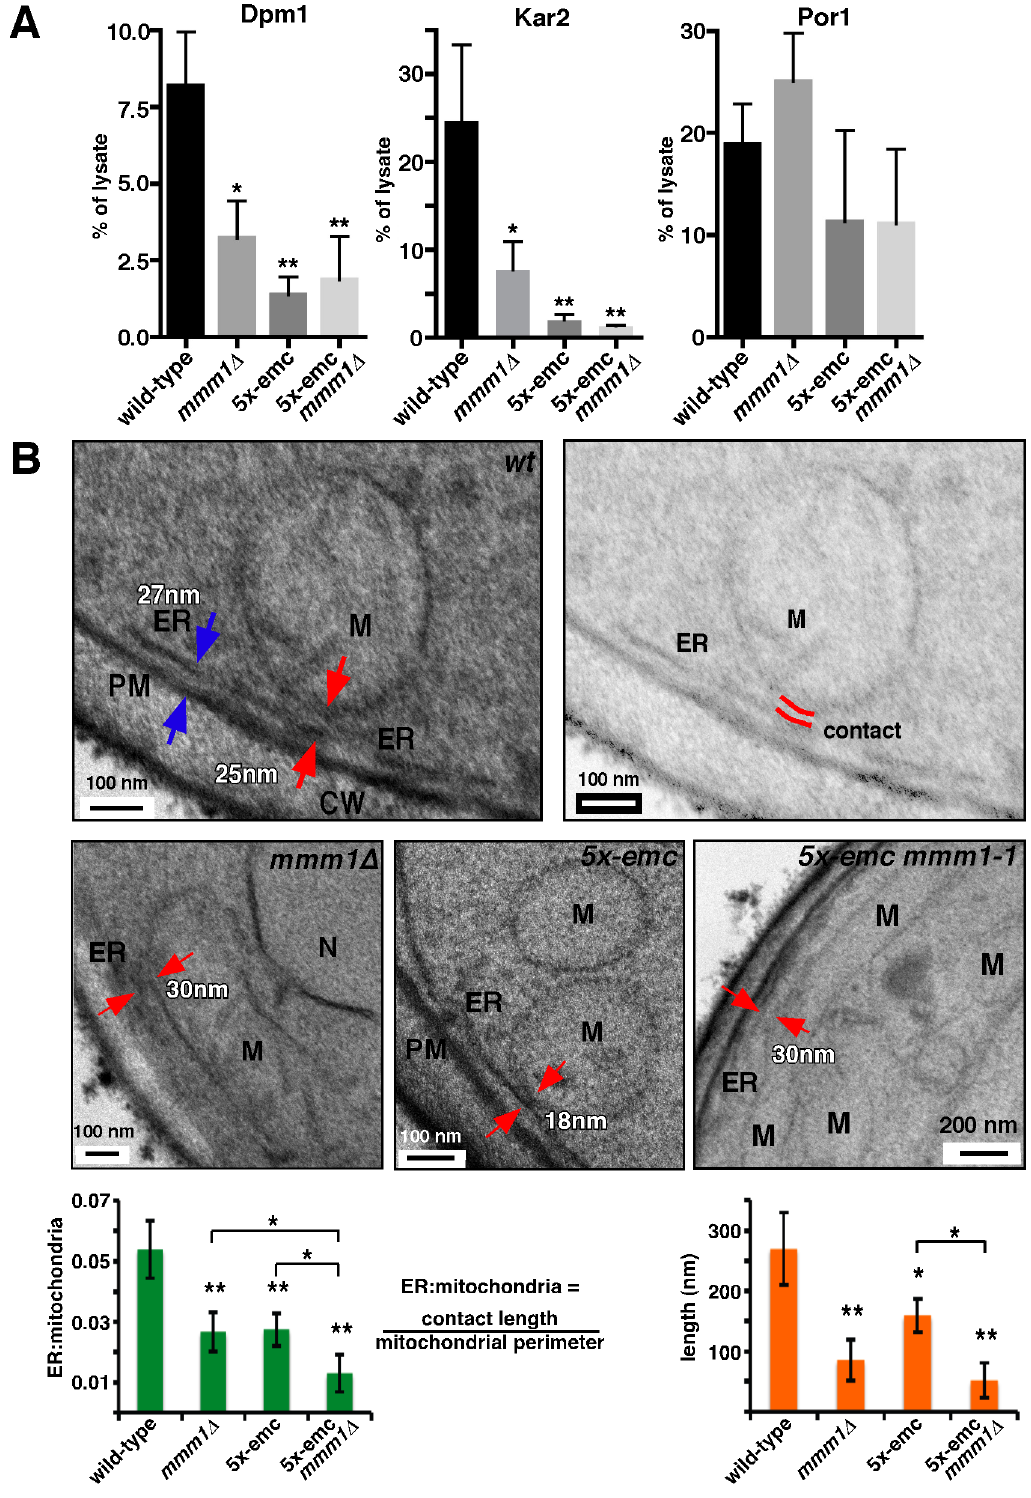
Figure 7. Cells lacking the EMC or the ERMES complex have reduced ER-mitochondria contacts. (A) Mitochondria were purified from the indicated strains and the percent of the ER proteins Dpm1 or Kar2 and the mitochondrial protein Por1 determined (mean 6 s.d., n =3 independent experiments). (B) Representative EM image shows a portion of a wild-type cell (top left). The same image is shown with reduced contrast (top right) to indicate the length of ER to mitochondria contact, highlighted with red lines. EM images showing portions of mutant cells are shown in the middle panels. Red arrows indicate a contact between the ER and mitochondria (M), and the blue arrows show a contact between the ER and the plasma membrane (PM). The bottom panels show the average ER–mitochondria ratio and average length of contacts (mean 6 s.d., n =15 individual cells). The ER–mitochondria ratio was determined by measuring the length of contacts between the ER and mitochondria divided by the length of mitochondrial perimeter in each image. * p , 0.05, ** p , 0.005 compared to wild-type, independent two-tailed t test. The data used to generate the graphs are in Table S7. doi:10.1371/journal.pbio.1001969.g007 PLOS Biology |